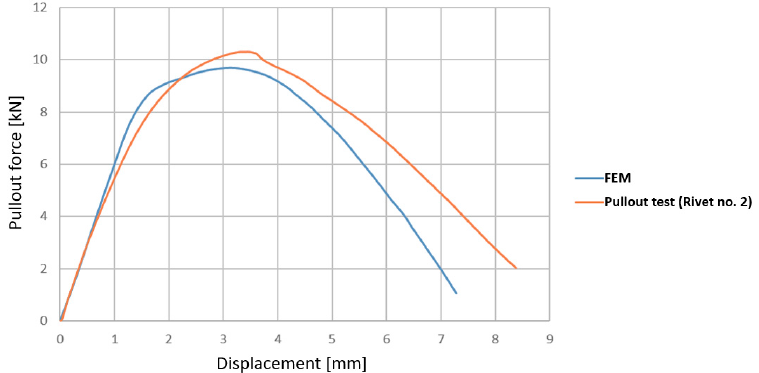
Figure 9. Comparison between experimental values and FE model of pullout tests.